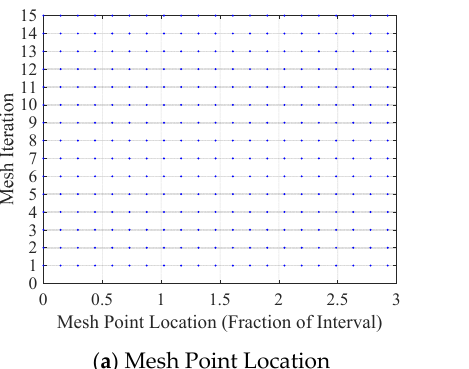
Figure 17. History of control for retargeting control optimization.